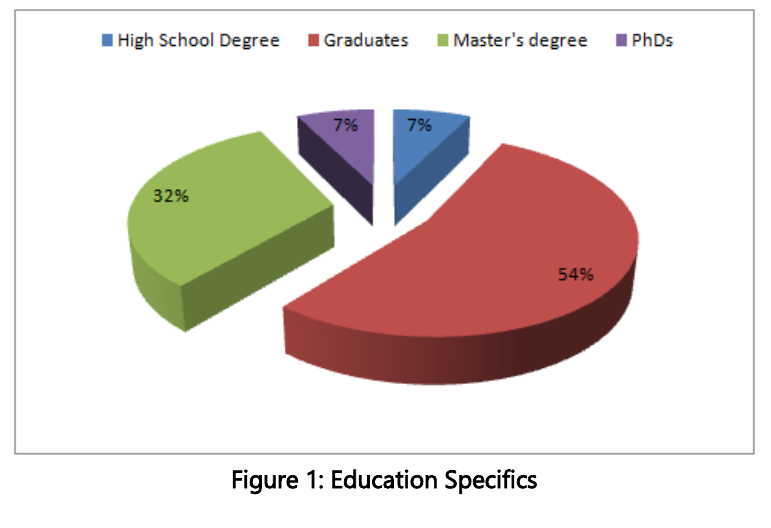
Figure 1: Education